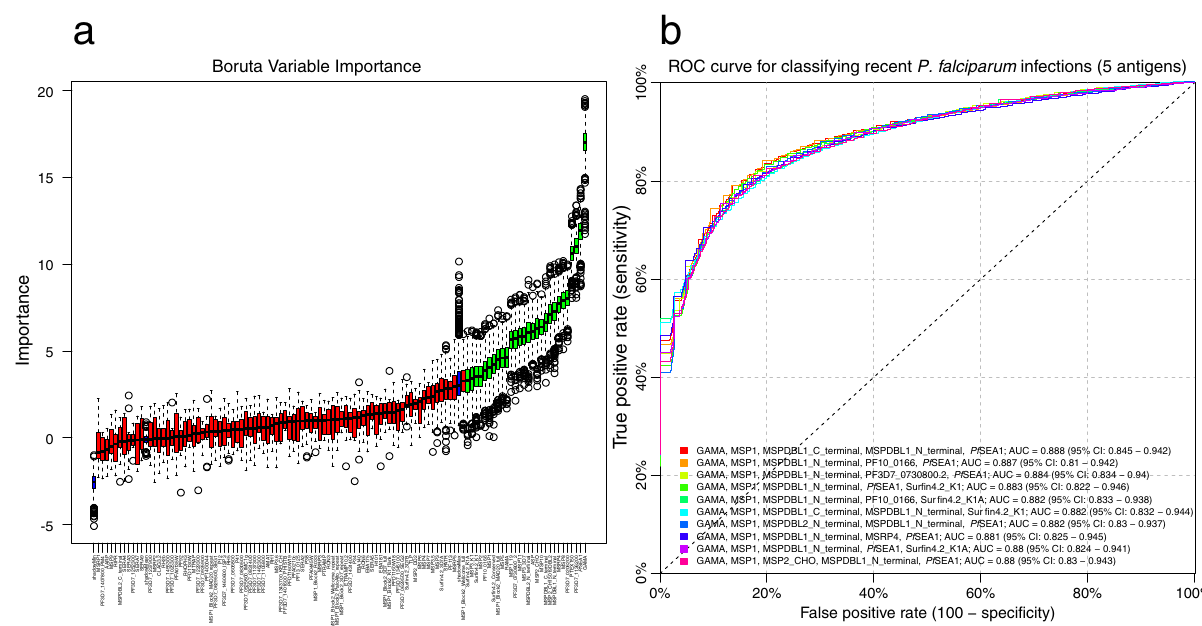
Fig. 4 Feature selection of antibody responses and evaluation of most informative antibody combinations. a Variable importance plot for classi fi cation performance determined using a Boruta feature selection algorithm as described by Kursa and Rudnicki. The Boruta algorithm was fi tted jointly to data for all antibody responses in all samples ( s = 282) from study participants and controls ( n = 107). Antibody responses are ordered from left to right by their importance for classi fi cation. The importance measure is de fi ned as the Z-score of the mean decrease accuracy (normalised permutation importance). Blue boxes correspond to the minimal, average, and maximum Z-scores of shadow features. Red boxes indicate variables not contributing signi fi cantly to accurate classi fi cation. Green boxes indicate the 28 antibody responses contributing signi fi cantly to classi fi cation that were selected for further evaluation. The centres of boxes correspond to the median. The lower and upper hinges of boxes correspond to the fi rst and third quartiles of the data. The upper and lower whiskers extend from the hinges to the largest and smallest values, respectively, no further than 1.5 * the interquartile range from the hinges. Data beyond the end of the whiskers are plotted individually. b Cross-validated receiver operating characteristic (ROC) curves. Random forest classi fi ers fi tted to data on antibody responses to the top 10 combinations of 5 out of the 98280 possible combinations of the 28 selected antigens as determined by the classi fi er area under the ROC curve (AUC). An AUC of 0.5 indicates a classi fi er that performs no better than random, while an AUC of 1 indicates a perfect classi fi er. Rainbow coloured lines correspond to the ten classi fi ers with the highest cross-validated